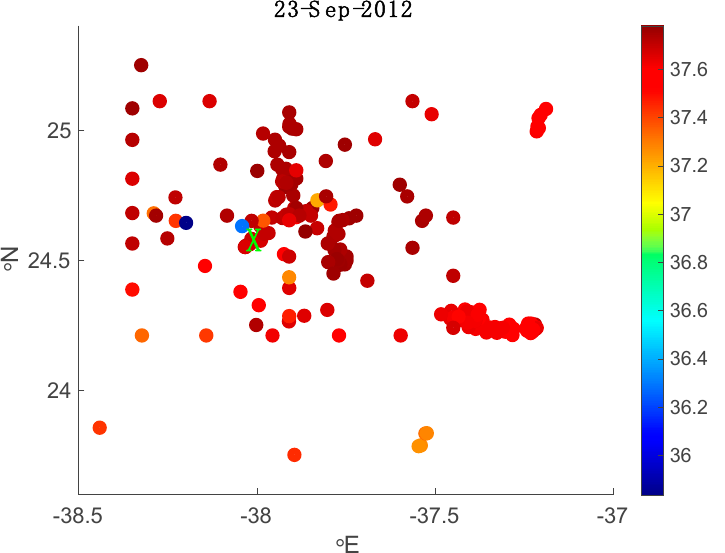
Figure 4. Distribution of SSS measurements for the 7-day period surrounding 23 September 2012 in the SPURS-1 region (small circles with color scale at right). The location of the central mooring is indicated by the green letter “X” at (24.6°N,38°W). The value of σ for this date is 0.23. SFV for the model was computed similarly. However, instead of 7-day values, SFV was computed at each daily time step. To perform the sum in Equation (3), I summed over model grid points within 100 km of the location of the central mooring.